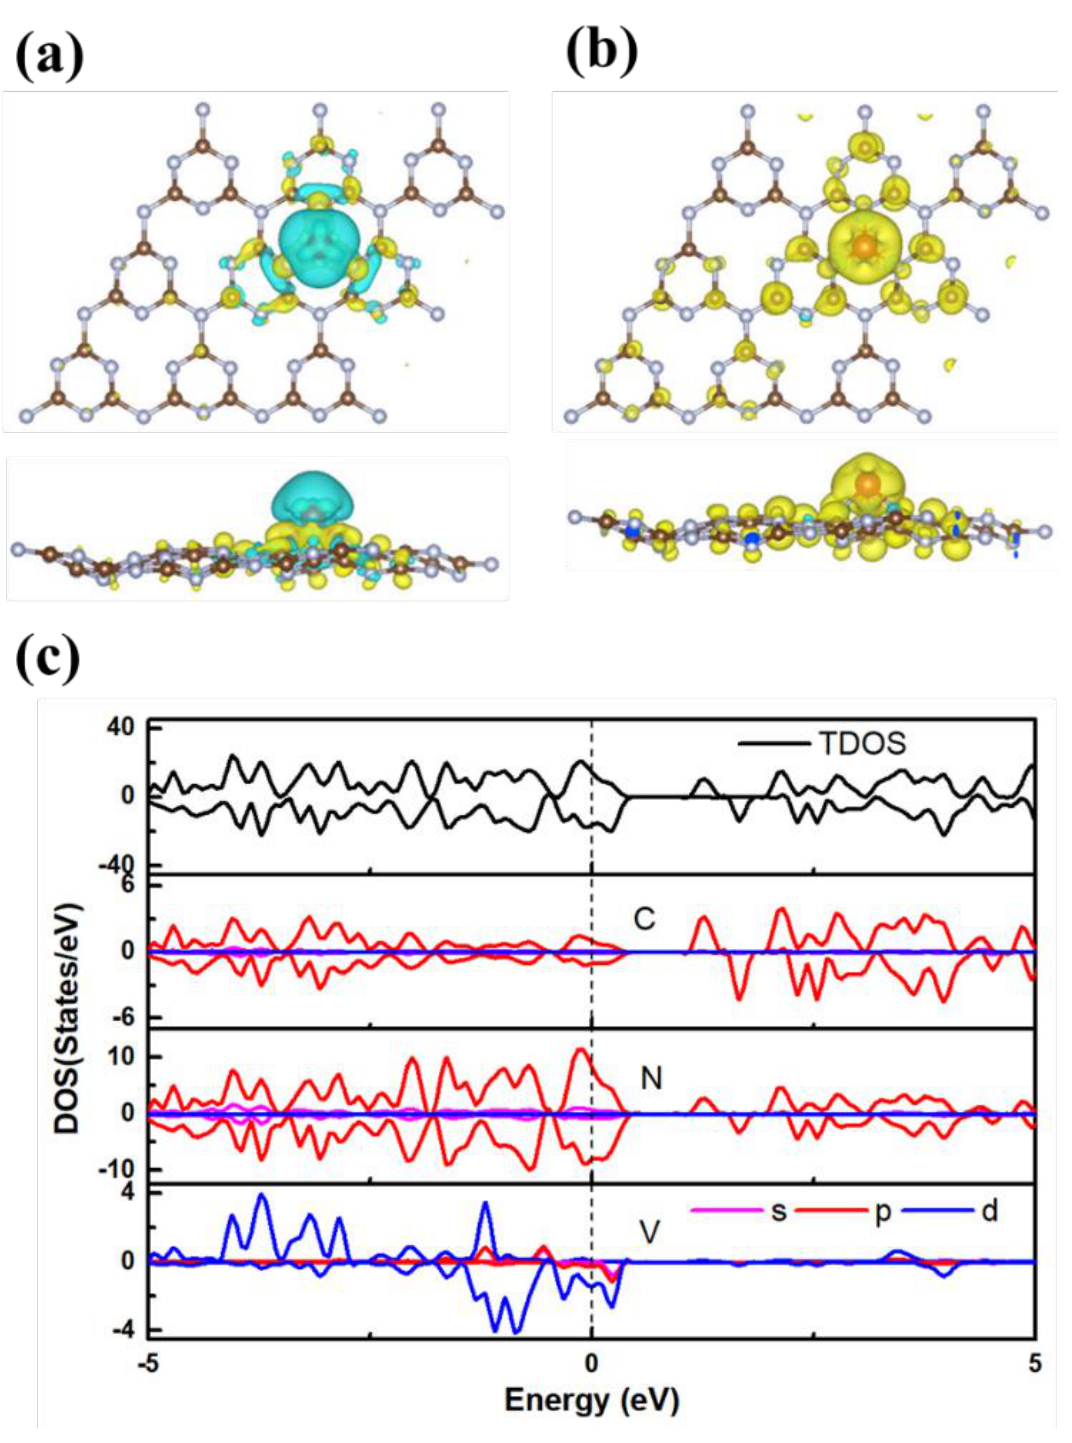
Figure 5. ( a ) Charge density difference with isosurface 0.004 e/Bohr 3 , the yellow and blue areas represent the accumulation and depletion of electrons, ( b ) spin density, the yellow and blue regions represent the spin-up and spin-down states, ( c ) DOS of V@g-C 3 N 4 , the Fermi level is set to 0 eV.